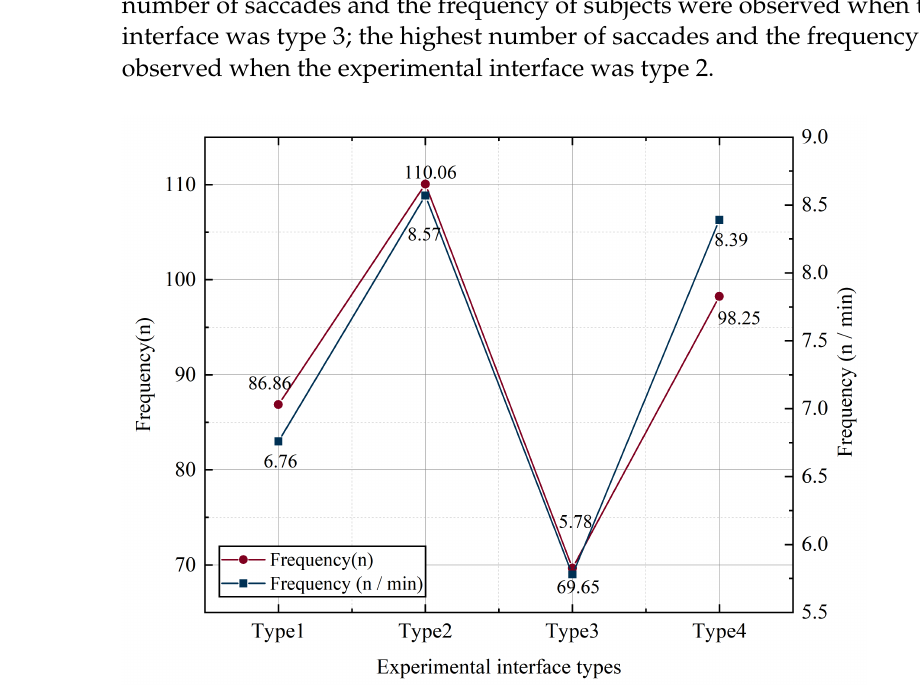
Figure 2. The number and frequency of saccades with different key